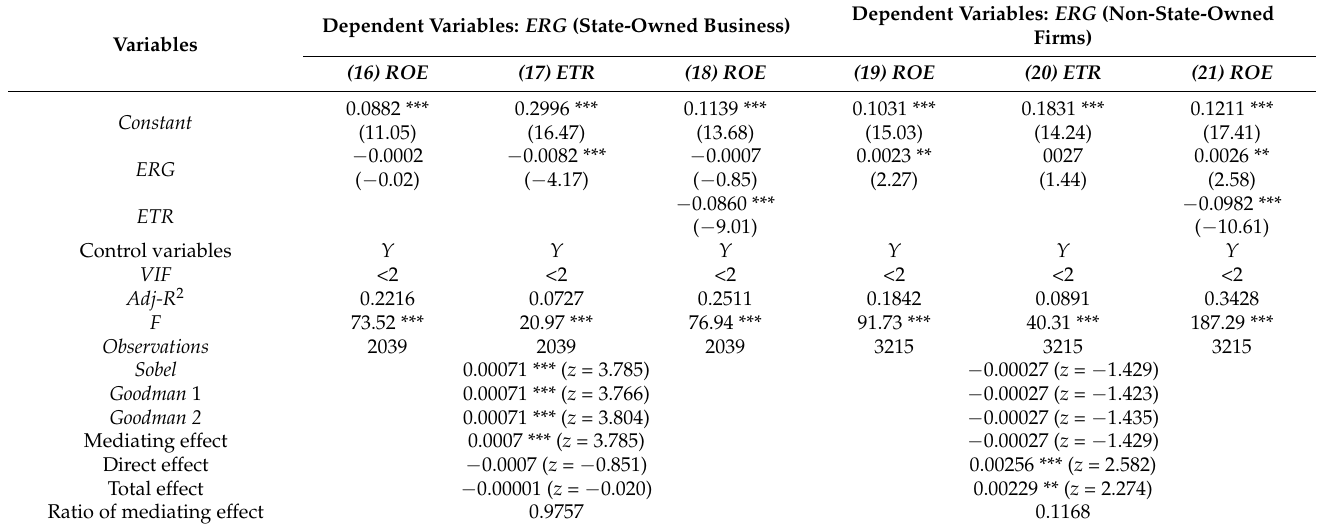
Table 12. Robustness testing of different measurement indicators (Considering Firm